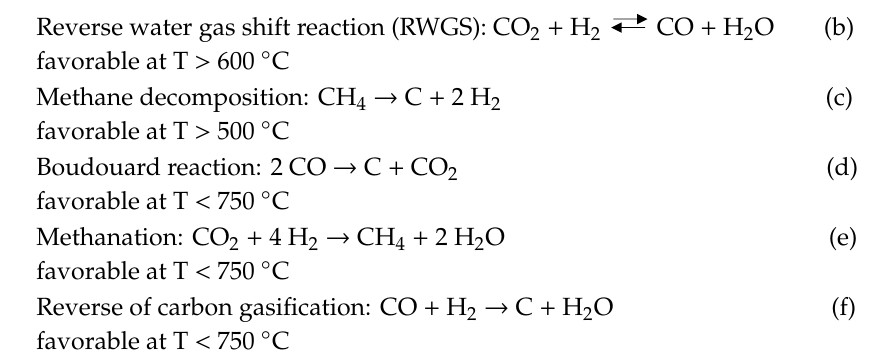
Figure 8. H 2 /CO molar ratio in DRM versus reaction temperature for the catalyst Co 2 Ni 2 Mg 2 Al 2 800 with and without